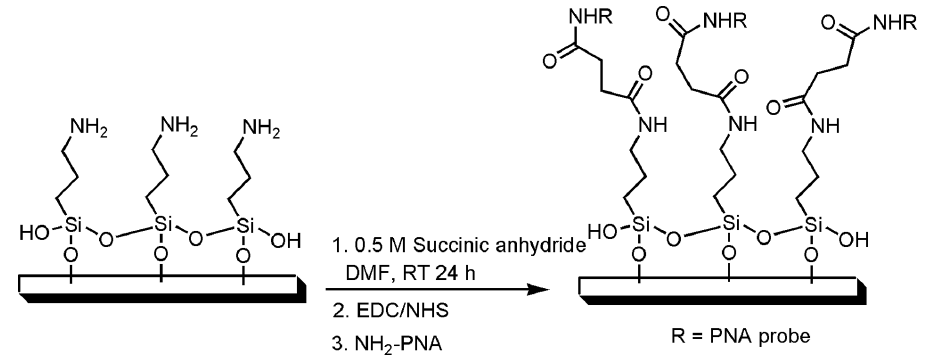
Figure 3. Chemistry of glass surface modification with PNA probe.